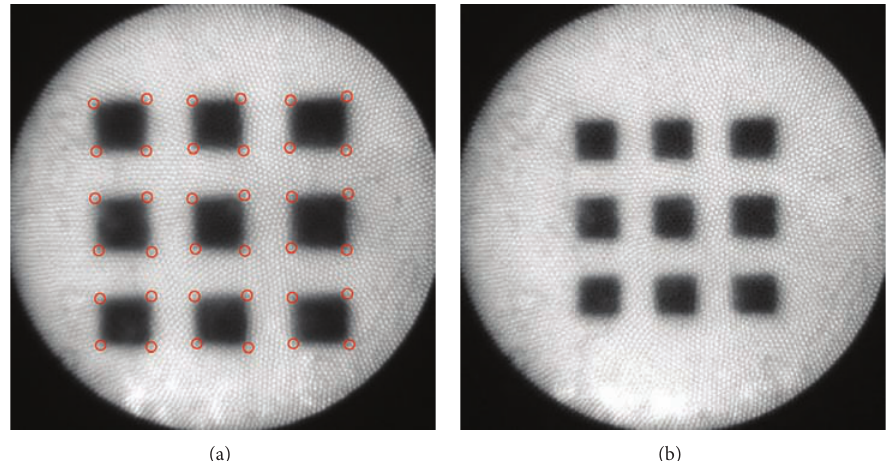
Figure 6: A chessboard pattern for camera calibration, recorded at (a) near and (b) far 𝑧 positions. Red circles in (a) indicate the automatically detected corner